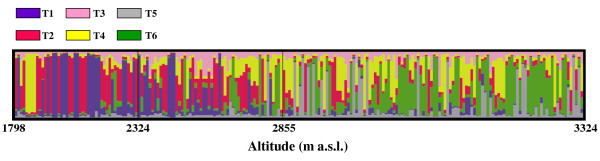
Population structure along the altitude gradient using TESS. TESS assignment at K = 6 for the 212 individuals, ordered according to crescent altitude levels. Blue-purple, T1; red, T2; pink, T3; yellow, T4; grey, T5; green, T6.